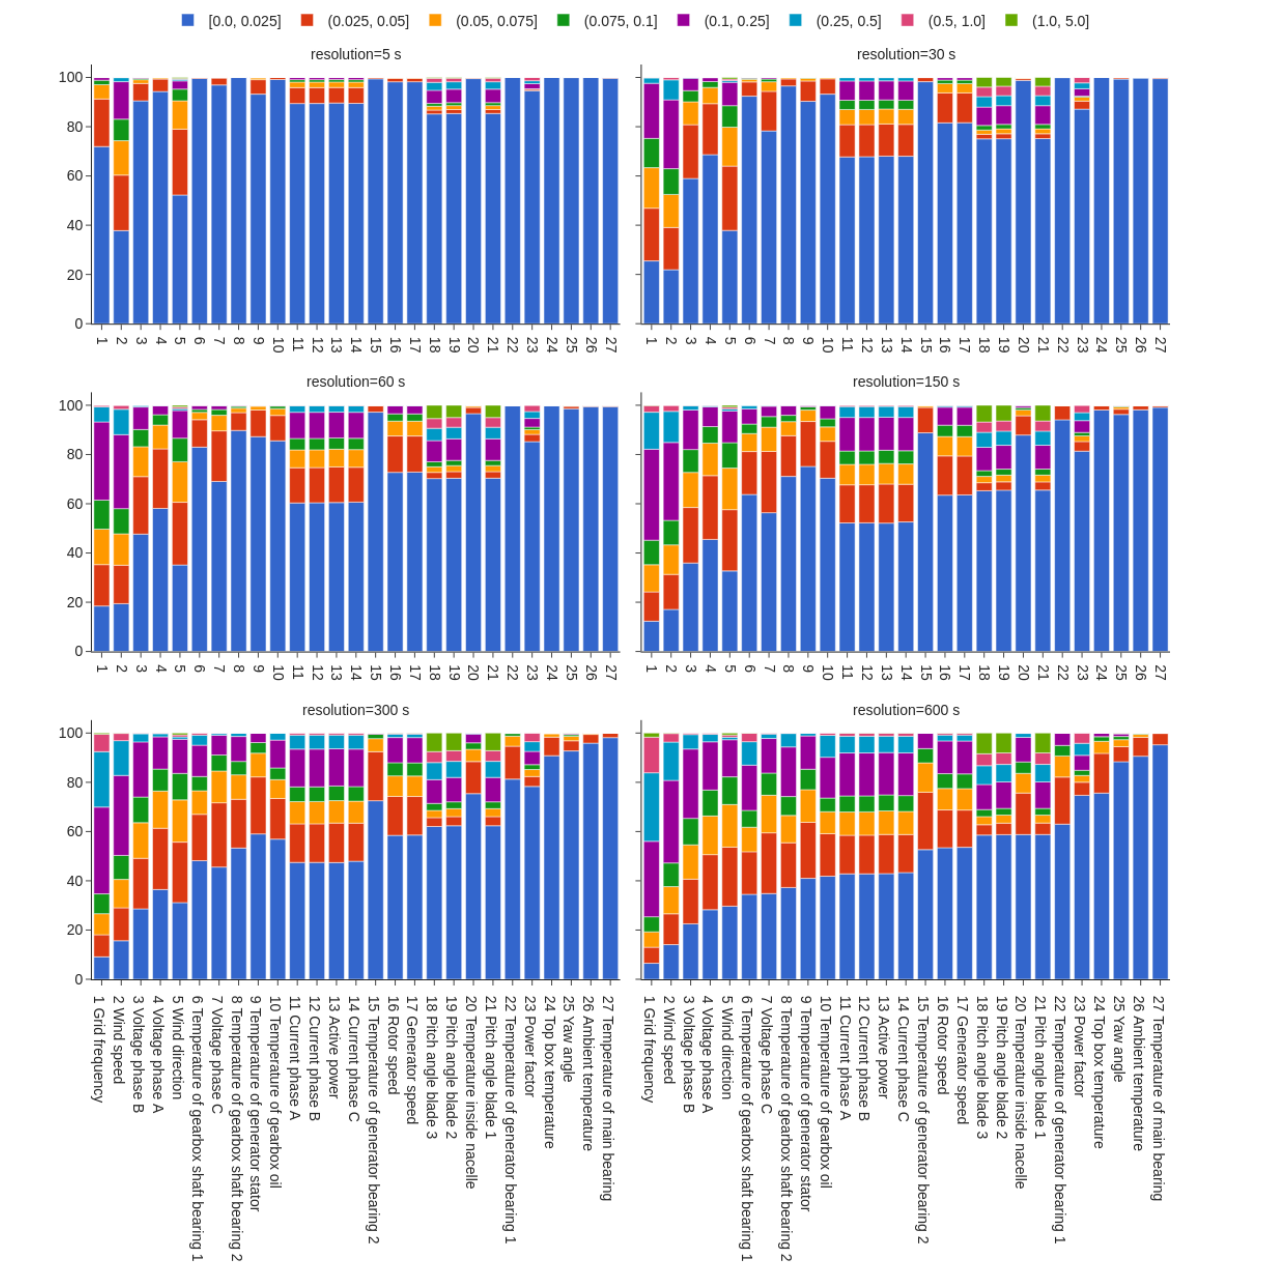
Figure 5. Information loss results for all the available signals and various aggregation ranges. Error values are normalized and discretized into bins, defined as fractions of the IQR value. Colors represent the error fraction bins. Signals are identified by a number in the bottom-most row for improving the readability in the upper